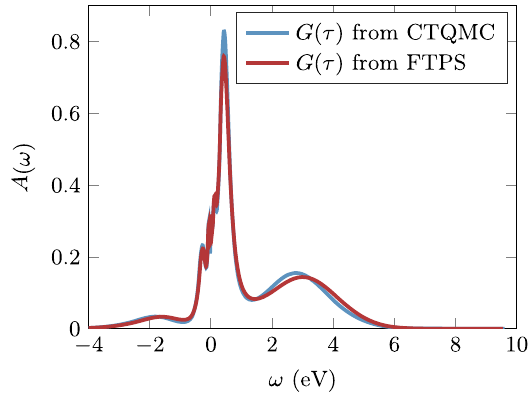
FIG. 7. Spectral functions from analytically continued imaginary-time Green ’ s functions G ð τ Þ calculated by CTQMC (blue line) and by FTPS (red line). Clearly, the analytic continu- ation cannot resolve the peak structure in the upper Hubbard